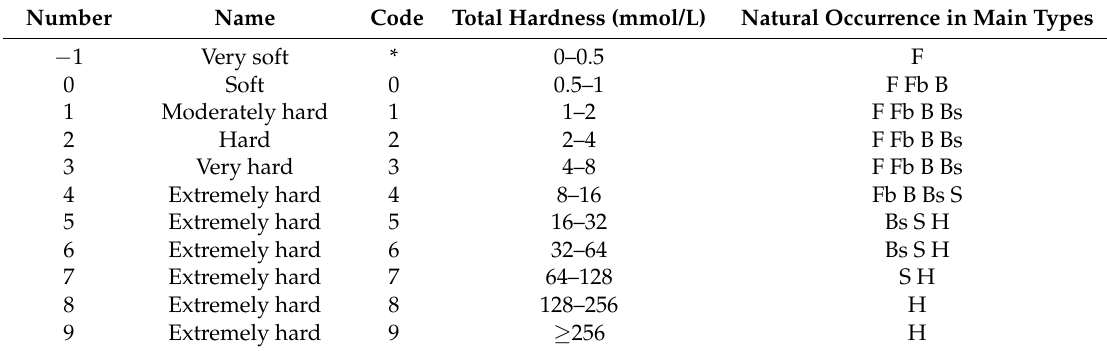
Table 4. Subdivision of the main types based on hardness [65]. Table 4. S ubdivision of the main types based on hardness [65].